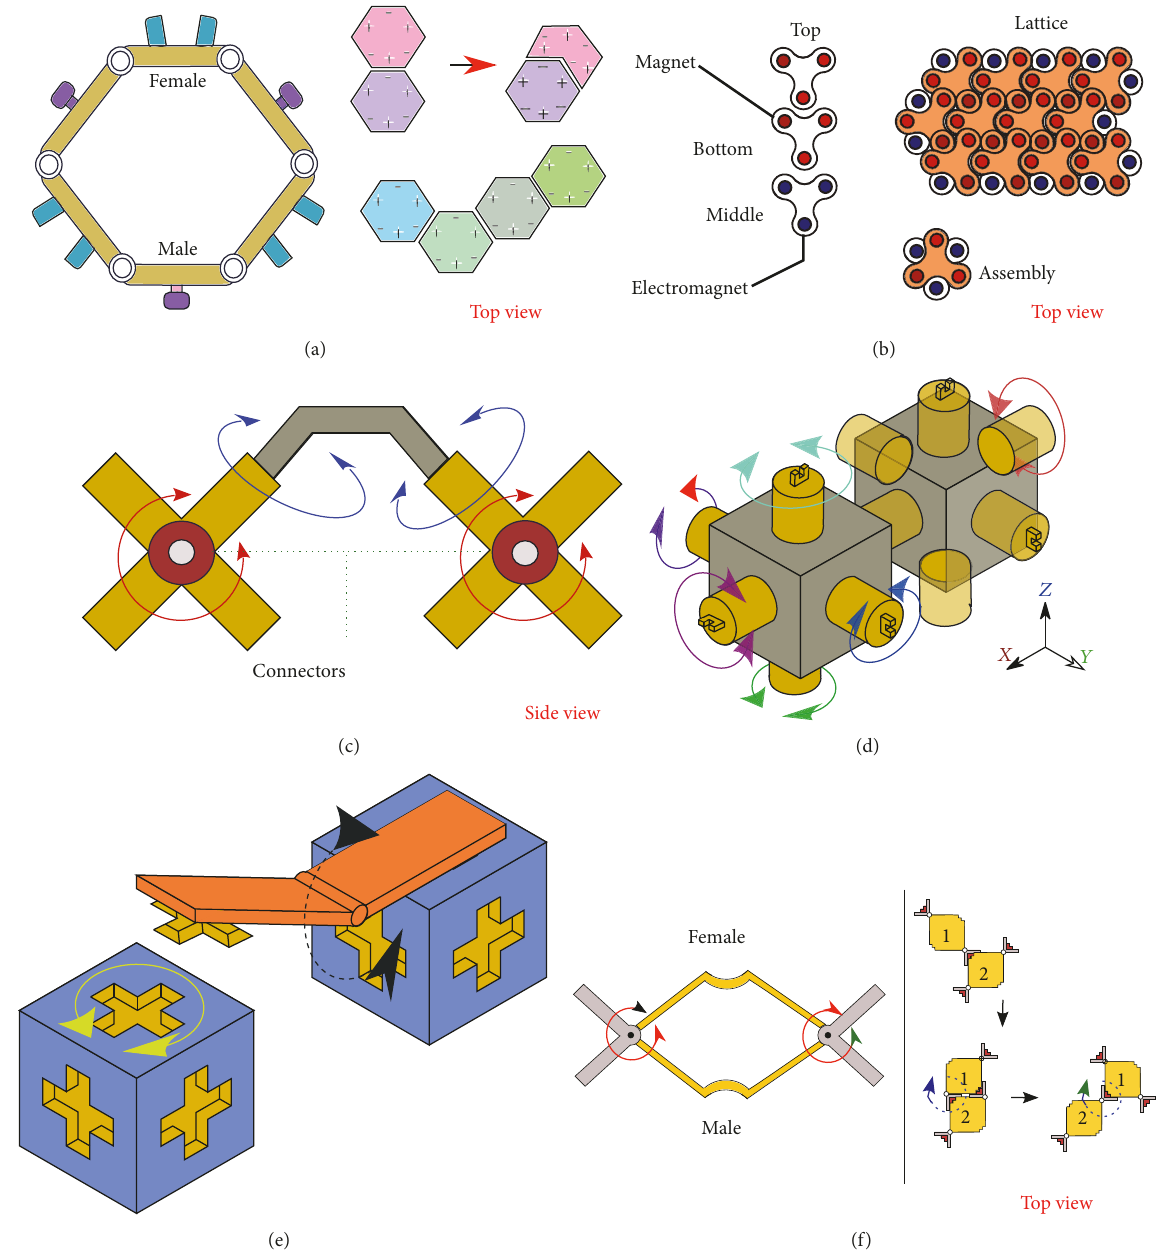
Figure 2: Lattice MSRR hardware models: (a) metamorphic, (b) Fracta, (c) molecule, (d) 3D unit, (e) I-cubes, and (f) Microunit